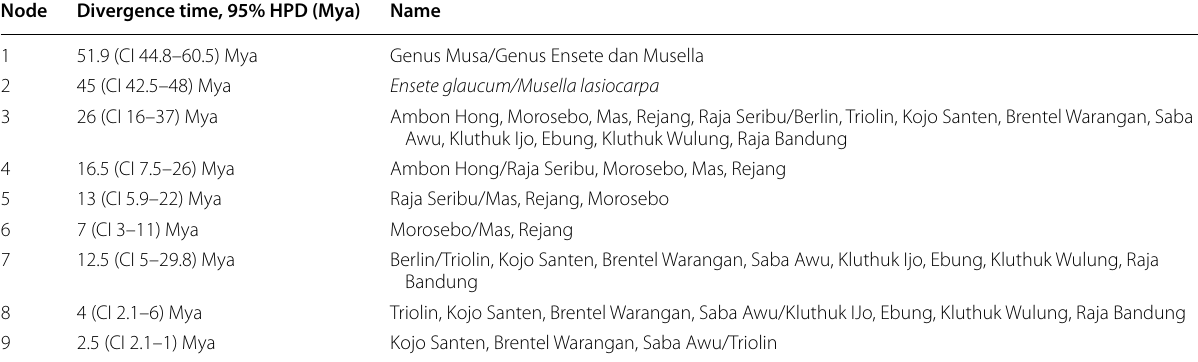
Mya Million years ago, CI confidence interval, HPD highest posterior